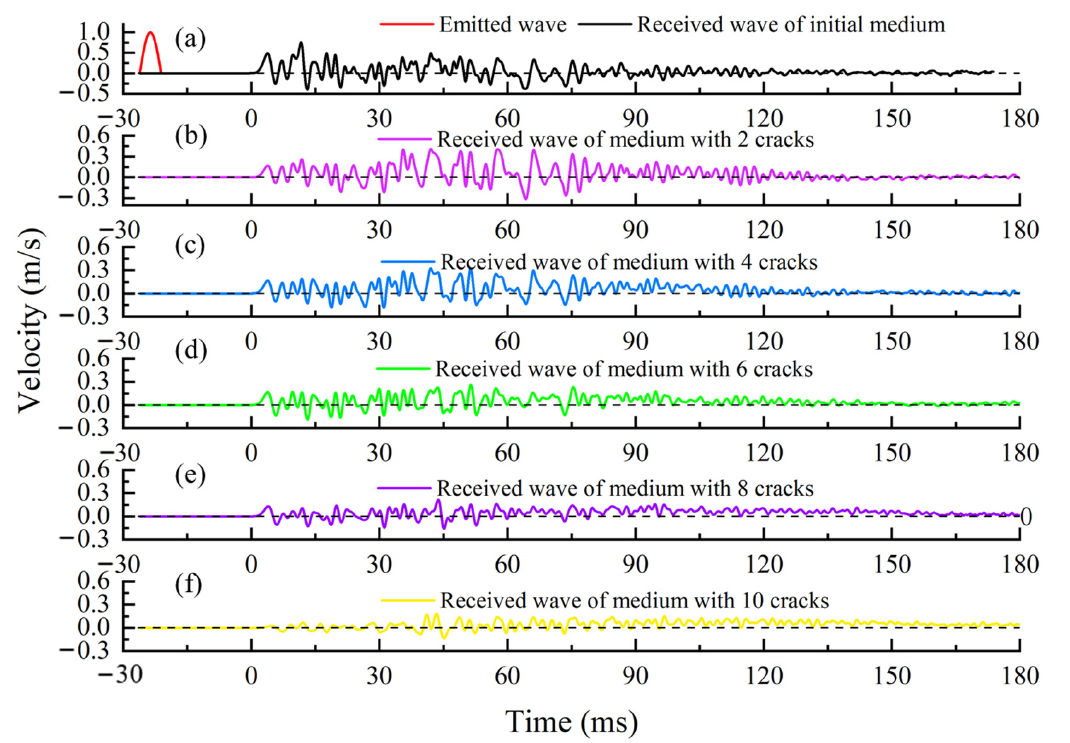
Figure 8. The emitted wave and the received waves of the medium with the different numbers of cracks.